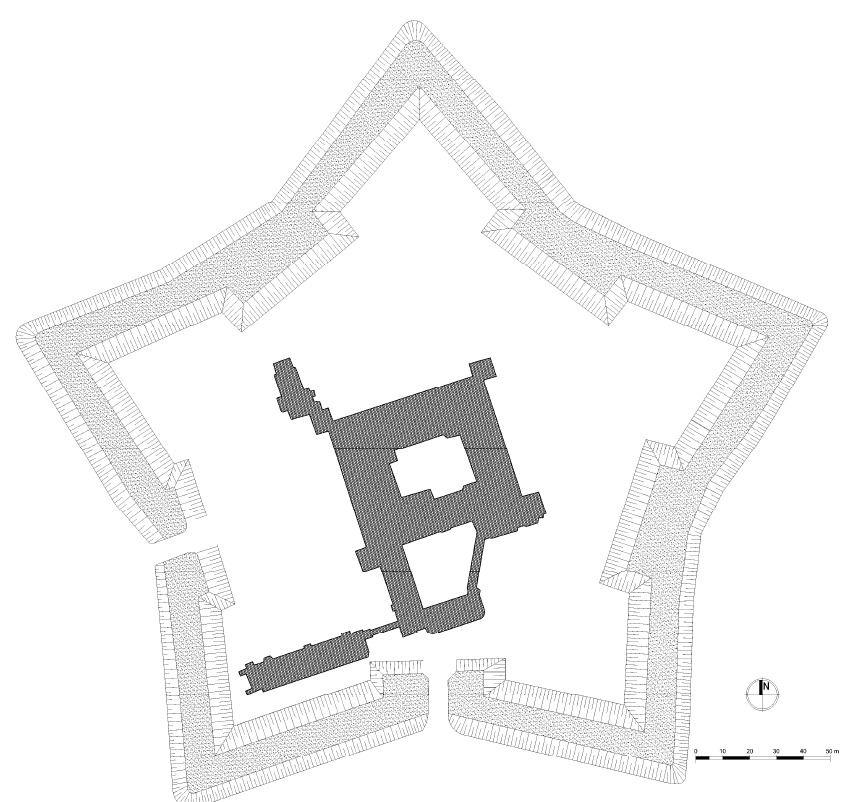
Figure 14. ( a ) Nowy Wi ś nicz: Lubomirscy’s residence—palace plan with fortifications; created by authors; ( b ) Ujazd: Krzy ż topór, Ossoli ń scy’s residence—palace plan with fortifications; created by authors.